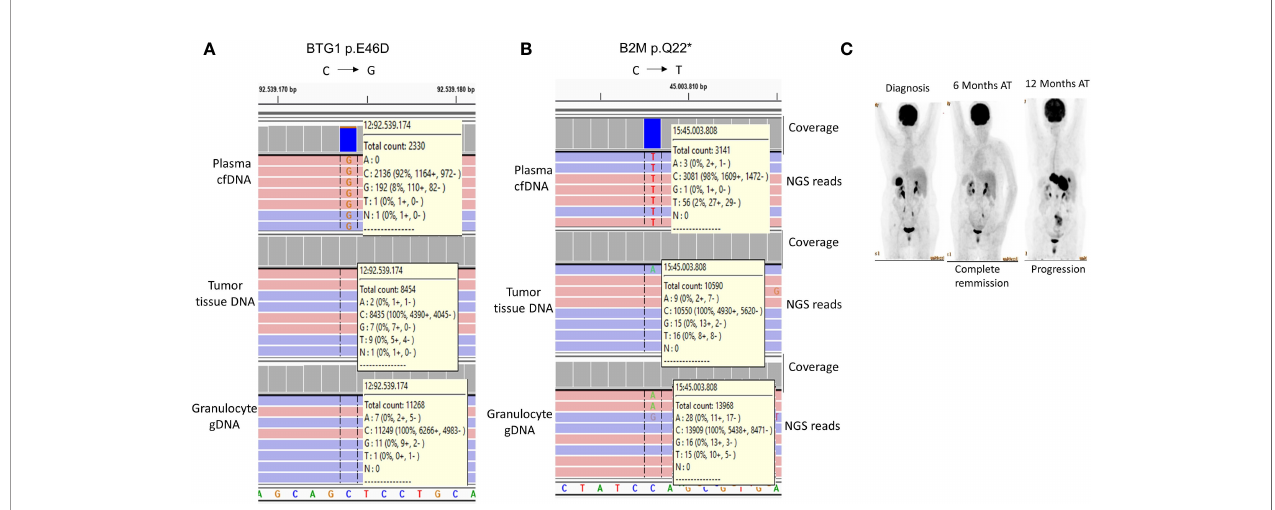
FIGURE 5 | Histological transformation-associated BTG1 and B2M mutations detected exclusively in cfDNA of a FL patient. IGV snapshots showing BTG1 p.E46D (A) and B2M p.Q22* (B) mutations in the plasma cfDNA sample of a FL patient (Case-16). The mutation status of the patient-matched granulocyte gDNA is also shown as a negative control sample. (C) FDG PET/CT images of Case-16 are shown before and after immunochemotherapy. AT, After